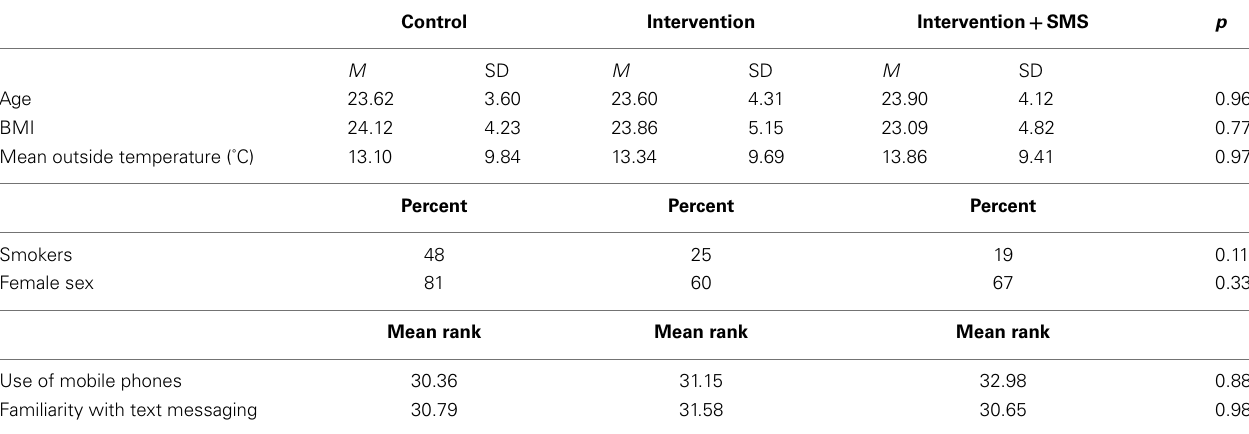
Table 1 | Sample characteristics and descriptive statistics.